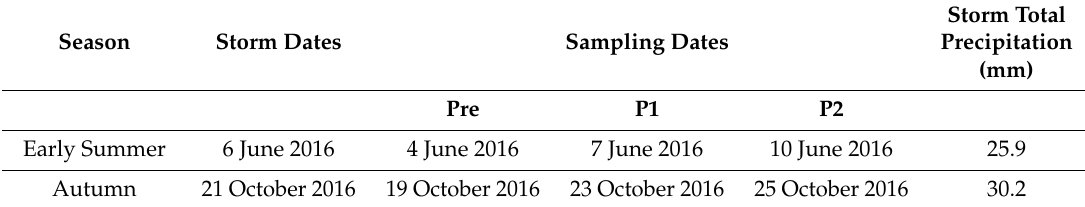
Figure 2. Total daily precipitation in mm and mean daily temperature in °C for the water year beginning 1 October 2015 through 31 October 2016. Precipitation is indicated by the solid line, temperature is indicated by the dashed line, and gray bars indicate the two storms. Table 2. Dates of storms and sampling events for the six lakes.